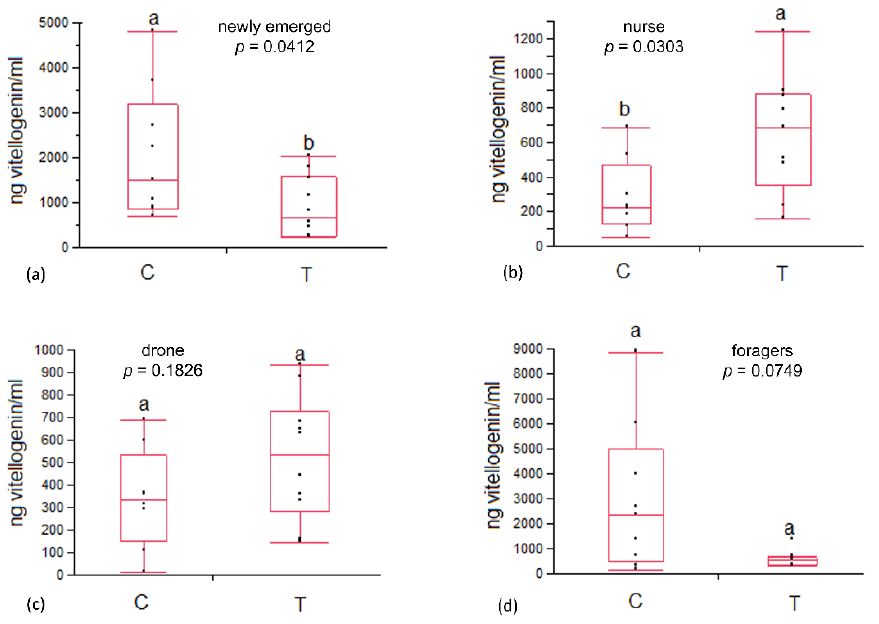
Figure 3. Vitellogenin content in ( a ) newly emerged, ( b ) nurse, ( c ) drone and ( d ) foragers belonging to control (C) and treated (T) colonies. Statistical differences are indicated with different letters. Table 1. Phenoloxidase activity in honey bees belonging to control and experimental colonies (queen caging + acid oxalic). Values are reported as mean±SE (median).